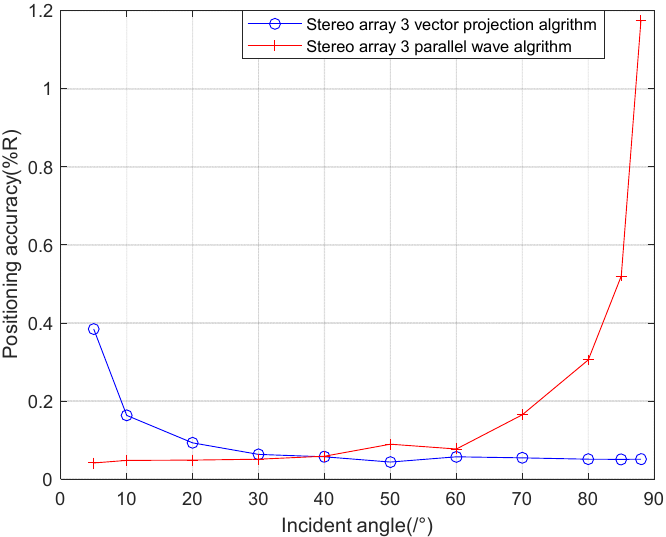
Figure 14. Positioning accuracy of stereo array 3 at different half included angles.